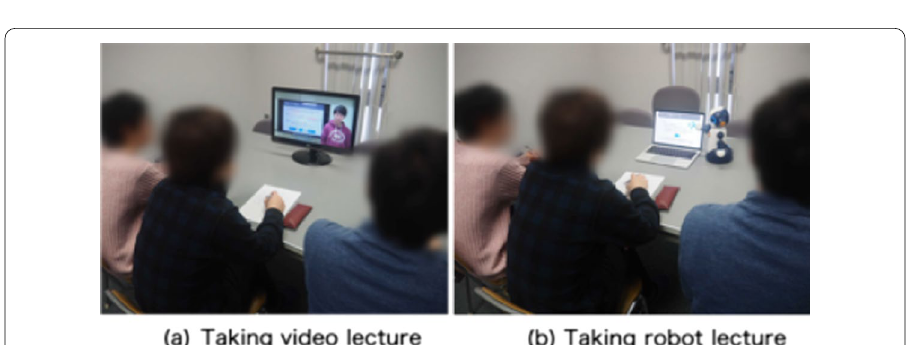
Fig. 9 Examples of taking a lecture by